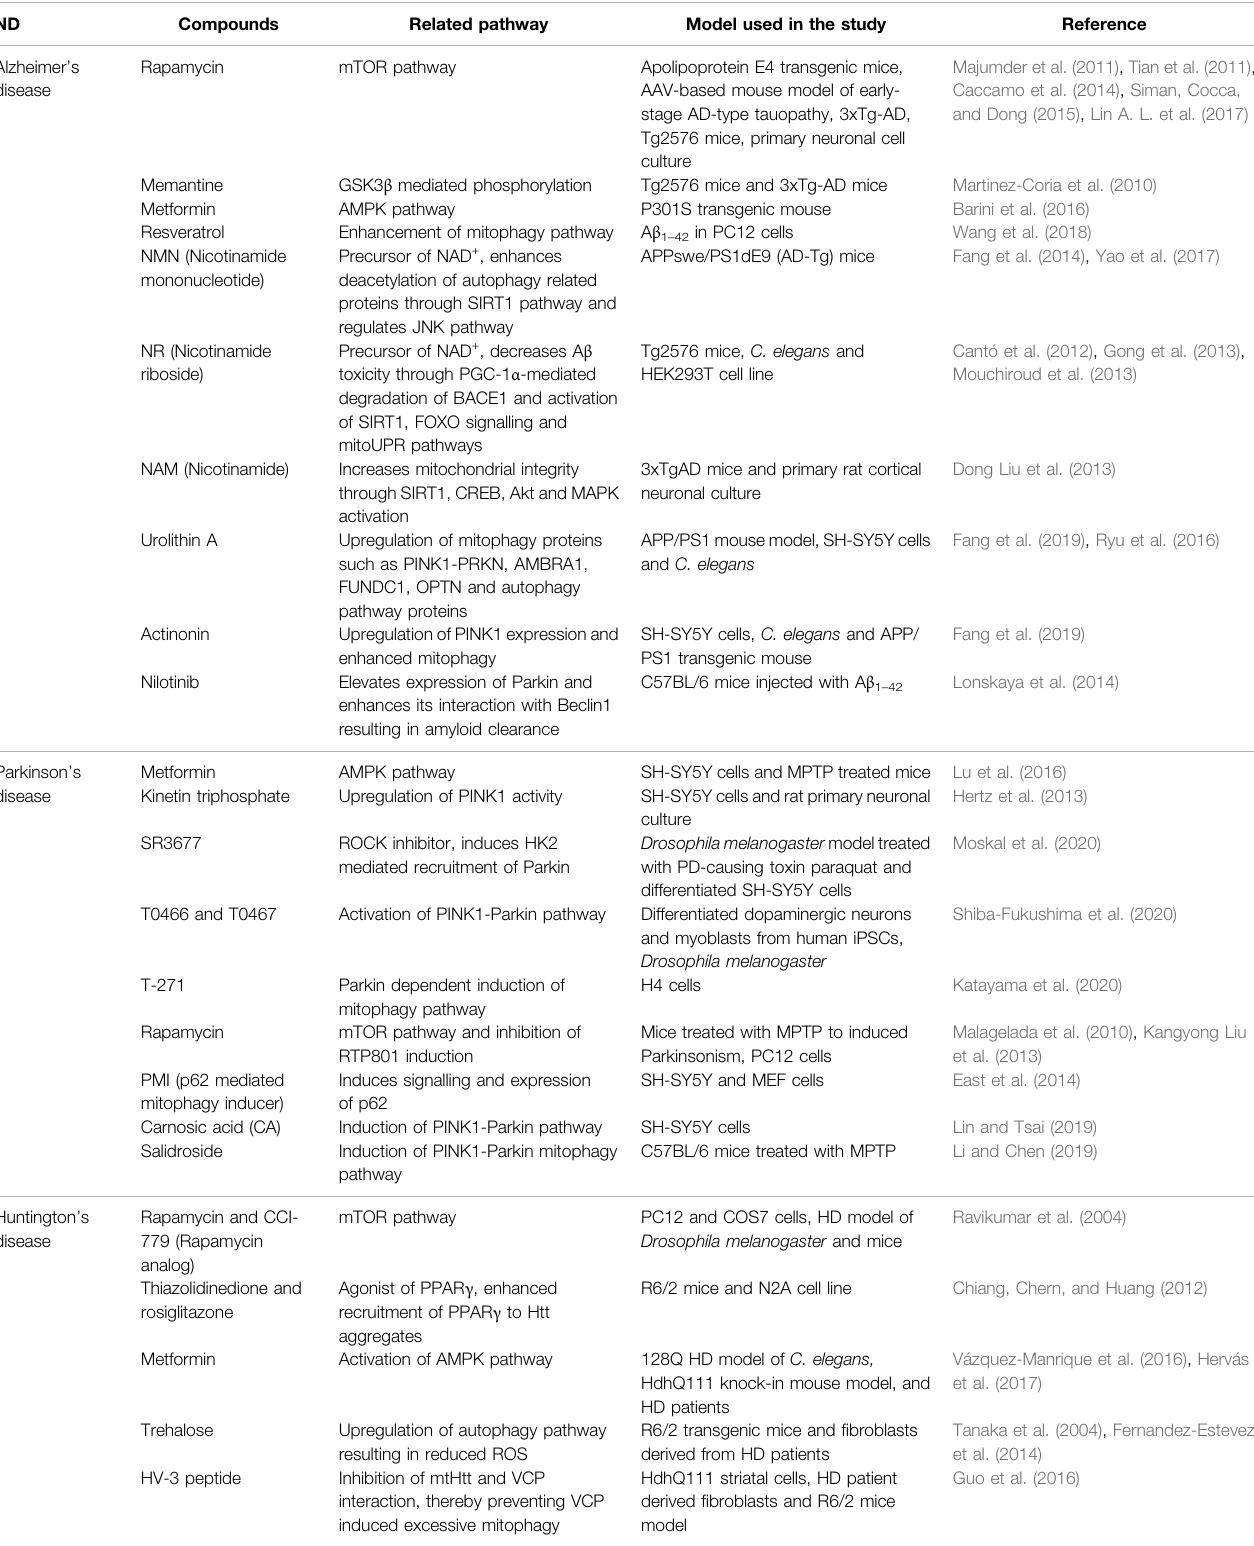
TABLE 2 | Therapeutic interventions in neurodegenerative disorders (ND) via the modulation of mitophagy pathway.